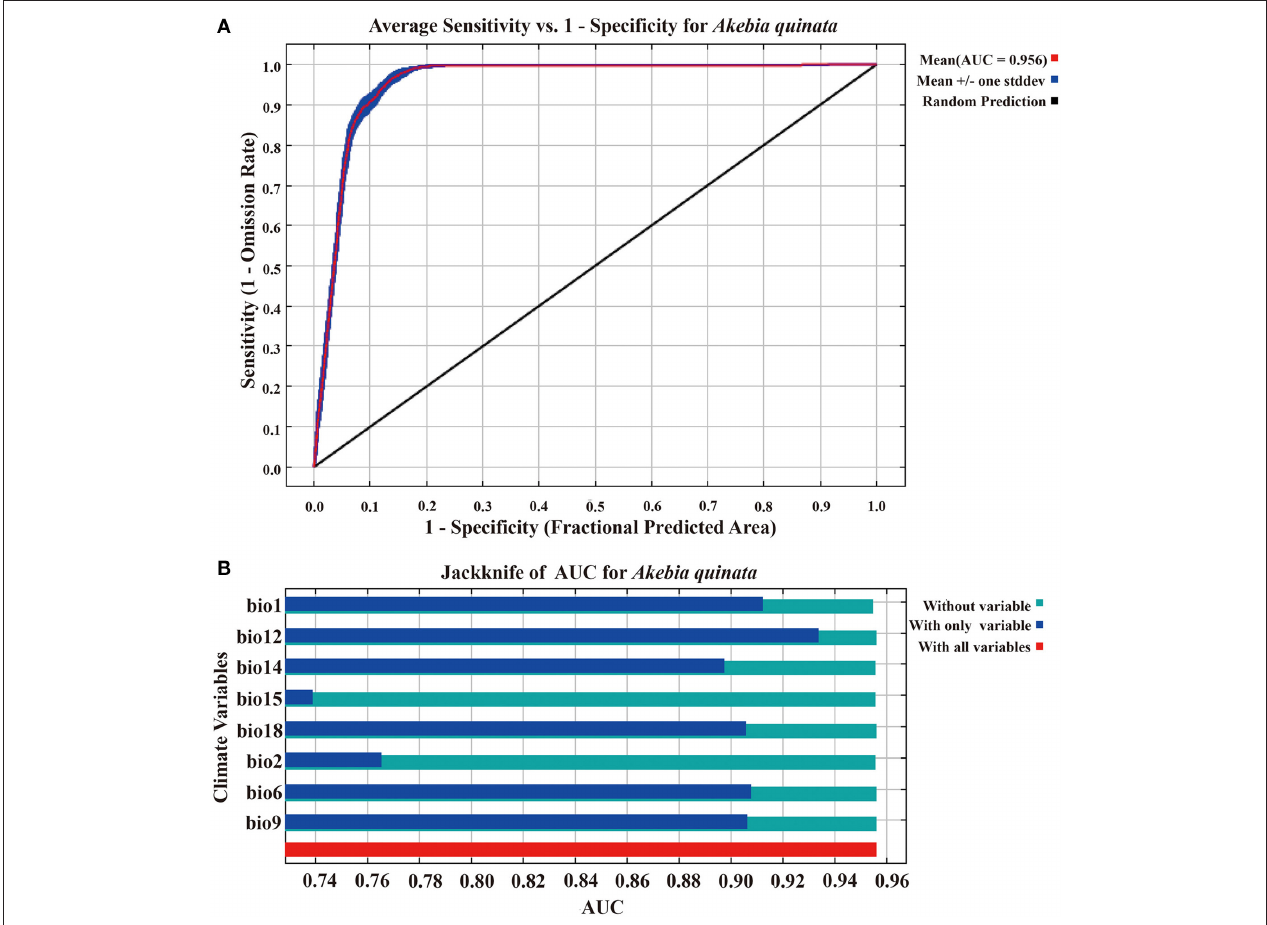
FIGURE 2 | The ROC curve analysis and Jackknife test of the MaxEnt model. (A) The ROC curve of the MaxEnt model (10 runs). (B) The Jackknife test of the MaxEnt model.